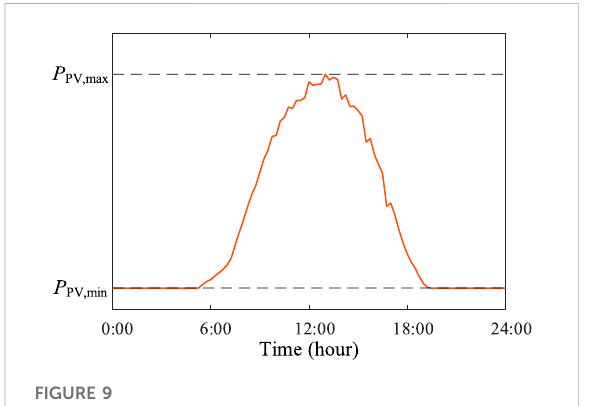
FIGURE 11 Voltage dynamic trends of the distribution system in one